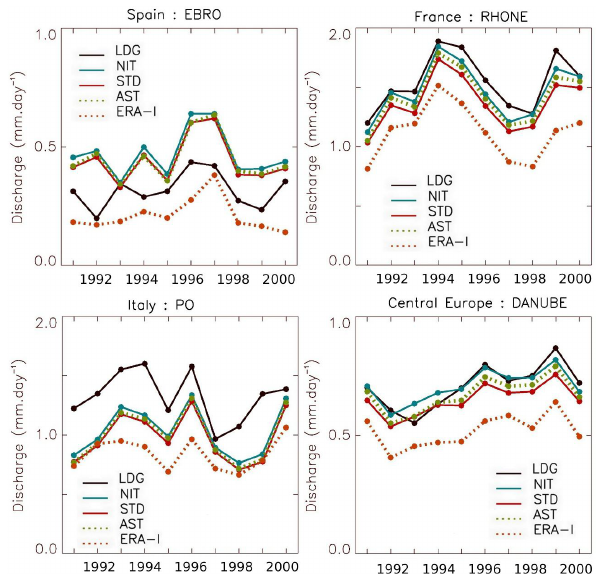
Fig. 14. Comparison of the time series of river discharge simulated in this study (coloured lines) by ERA-I, STD, AST, and NIT, with the observed/reconstructed data set (dark solid lines) of Ludwig et al. (2009), for (from left to right and from top to bottom) the Ebro, Rhone, Po, and Danube large rivers. Note that the total drainage ar- eas considered by TRIP at the outlet of these rivers are 85110km 2 , 92733km 2 , 82905km 2 , 813140km 2 , respectively. These outlet values may be higher than those given in Table 2 or in Fig. 11 for the most downstream inland